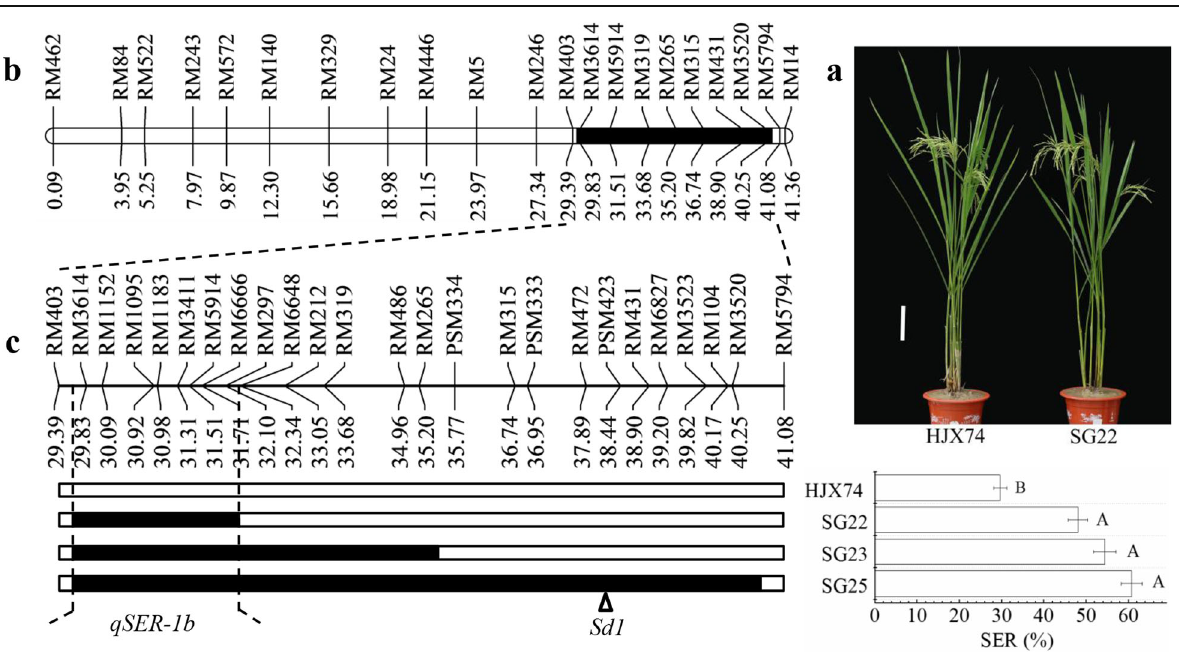
Fig. 2 Substitution mapping of qSER-1b . a Plant type of HJX74 and SG22. Scale bar, 15 cm. b The region of substituted segments of three SSSLs, SG22, SG23 and SG25, on chromosome 1. c Substitution mapping of qSER-1b , showing position of substituted segments and stigma exsertion rate (SER) of the SSSLs with HJX74 as the control. White and black blocks on chromosomes represent genotypes of HJX74 and donor, respectively. Threshold, α = 0.001, one-way ANOVA, Duncan, two-tailed. The triangle represents the locus of Sd1 (Sasaki et al.